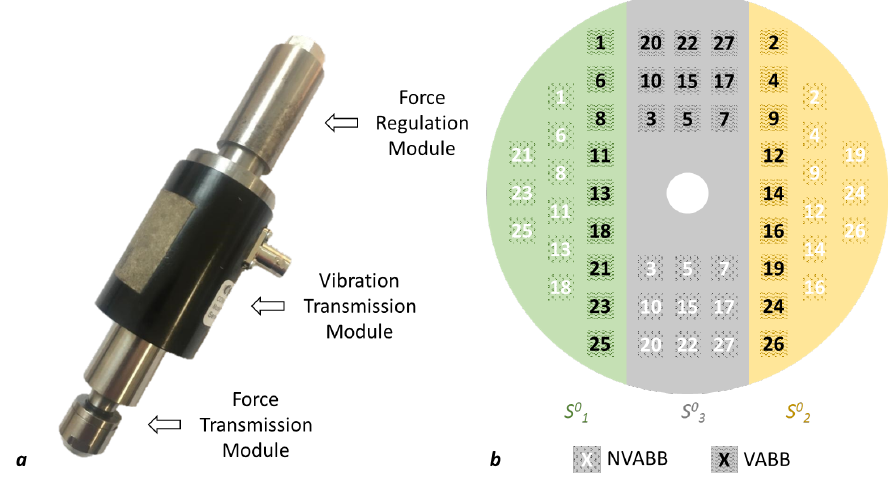
Figure 1. ( a ) Basic structure of the VABB tool used for the experiments. ( b ) Overview of the distribution of the 54 runs on the